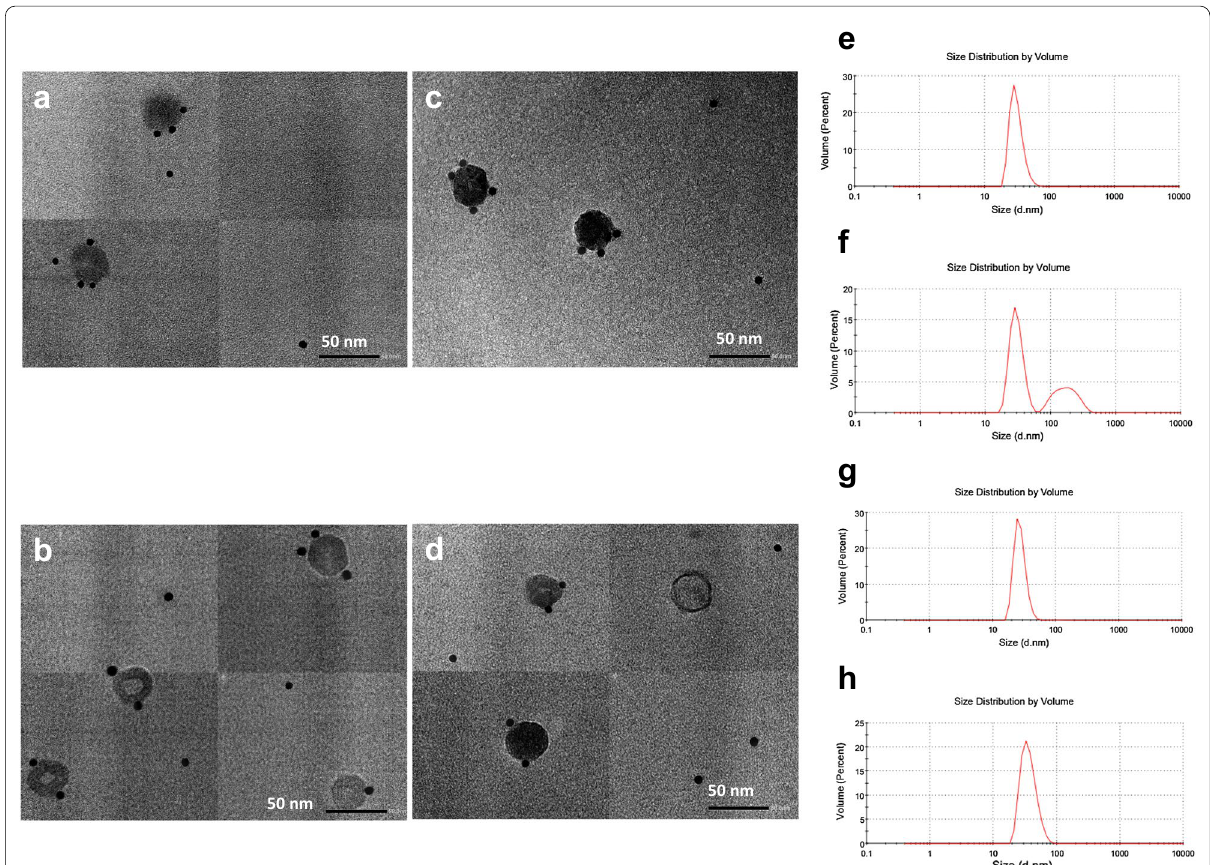
Fig. 4 The purified ( a ) 1CprME, ( b ) 1prME, ( c ) 4CprME, and ( d ) 4prME polypeptides were immunogold labeled using an anti-E polyclonal antibody and analyzed by IEM. Black spots in A, B, C, and D indicate the immunogold label. Dynamic light scattering (DLS) was used to analyze the size distributions of ( e ) 1CprME, ( f ) 1prME, ( g ) 4CprME and ( h ) 4prME